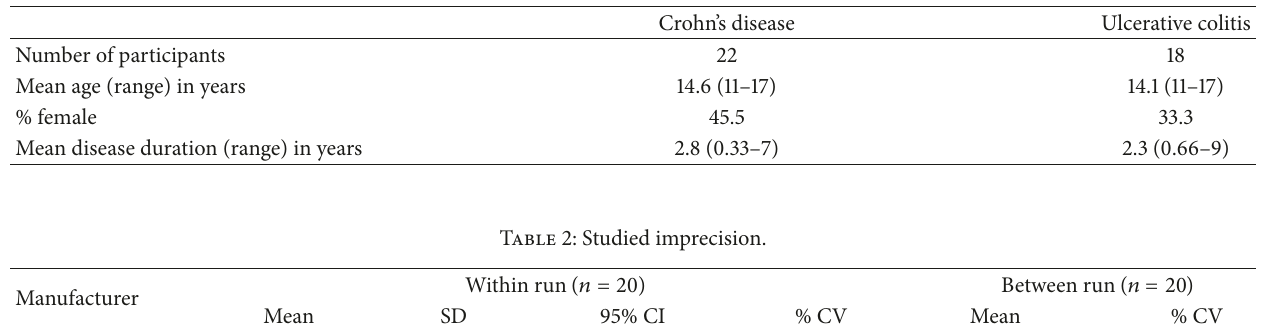
Table 1: Pediatric IBD patient demographic information.